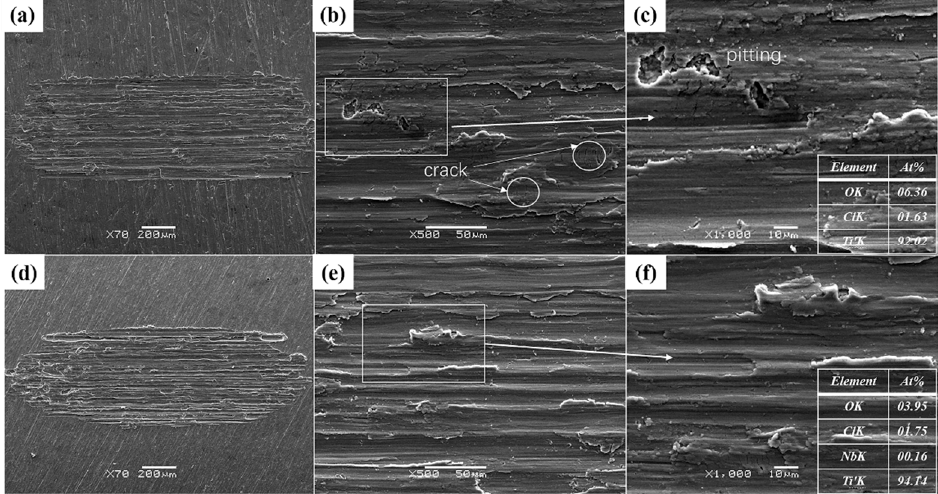
Figure 6. The worn surface and EDS analysis of samples: ( a – c ) substrate; ( d – f ) Nb-implanted sample.